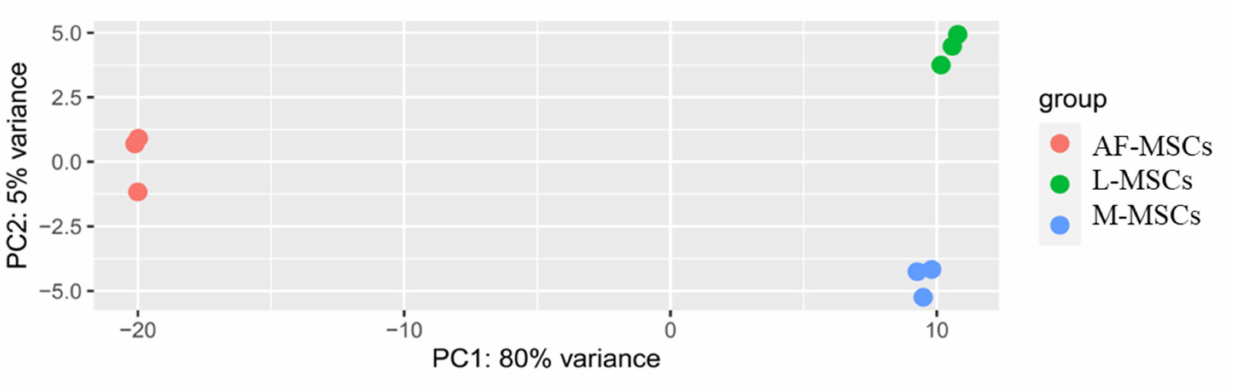
Figure 3. Principal Component Analysis (PCA) shows the variance of samples analysed in the study, based on the full miRNA profile (2646 expressed miRNAs). The analysis was conducted using the DESeq2 package and the values on each axis represent the percentages of variation explained by the principal components. PC1, principal component 1; PC2, principal component